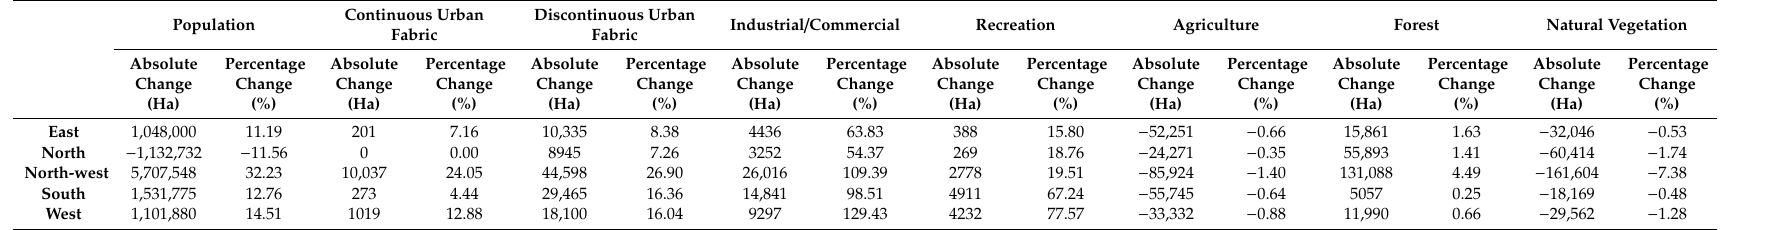
Table 3. Regional dynamics for land-use and population between 1990 and 2000.